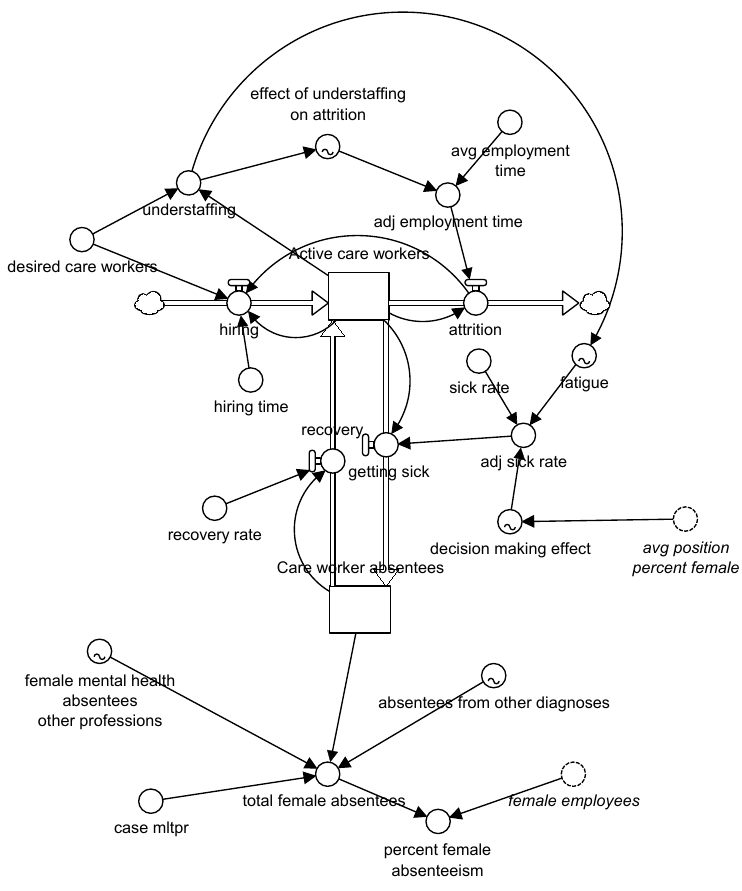
Figure 2. The stock and flow diagram for absenteeism in care work. Adj. = adjusted; Mltpr. = multiplier; Avg. = average.